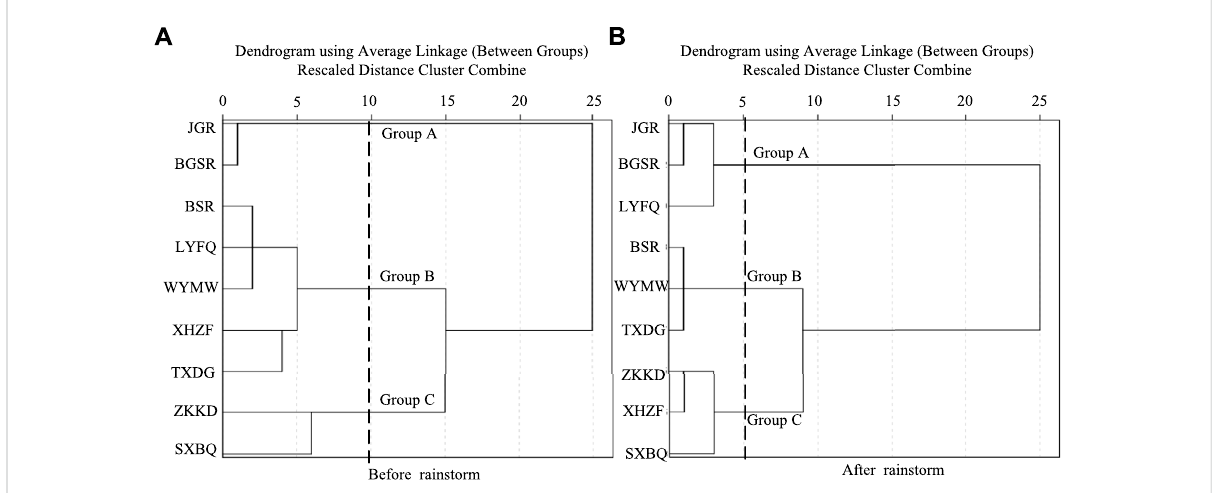
FIGURE 7 Spatial scale cluster analysis of the comprehensive water quality identi fi cation index before rainstorm (A) and after rainstorm (B) . The spatial differences of the comprehensive water quality identi fi cation index at each monitoring station before and after the rainstorm according to the dendrogram using Average Linkage (Between Groups) Rescaled Distance Cluster